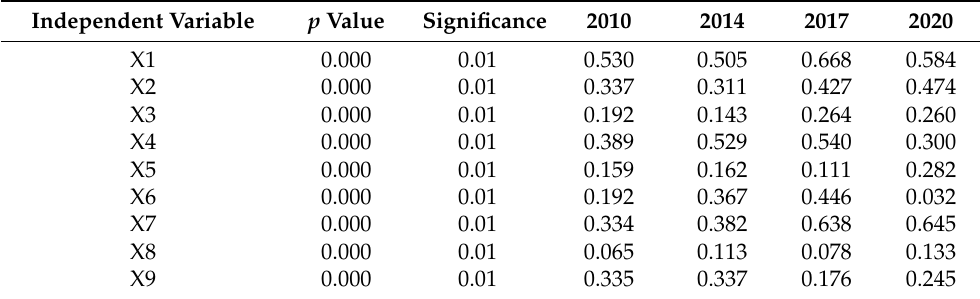
Table 7. Geodetector results of EWP in the TGRA in 2010, 2014, 2017, and